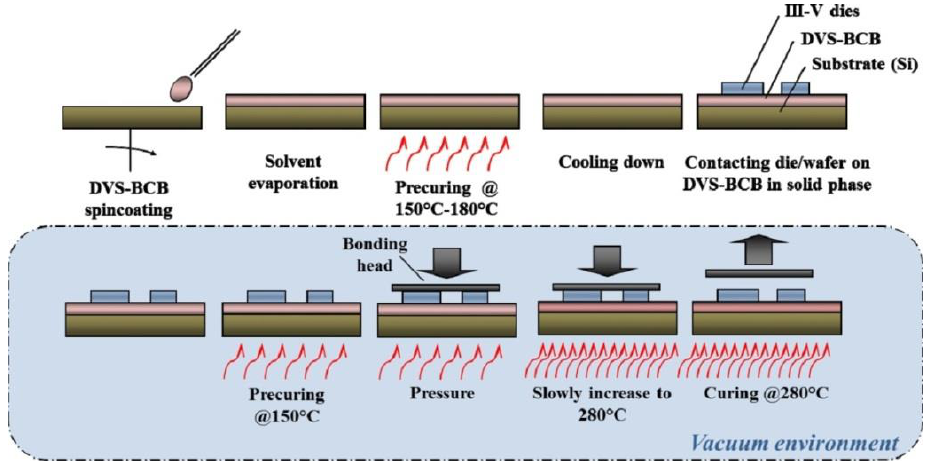
Figure 11. Silicon photonics integration process flow using bis-benzocyclobutene (BCB) bonding [115] (Reproduced with permission from Keyvaninia et al. , Opt. Mater. Express ; published by OSA,